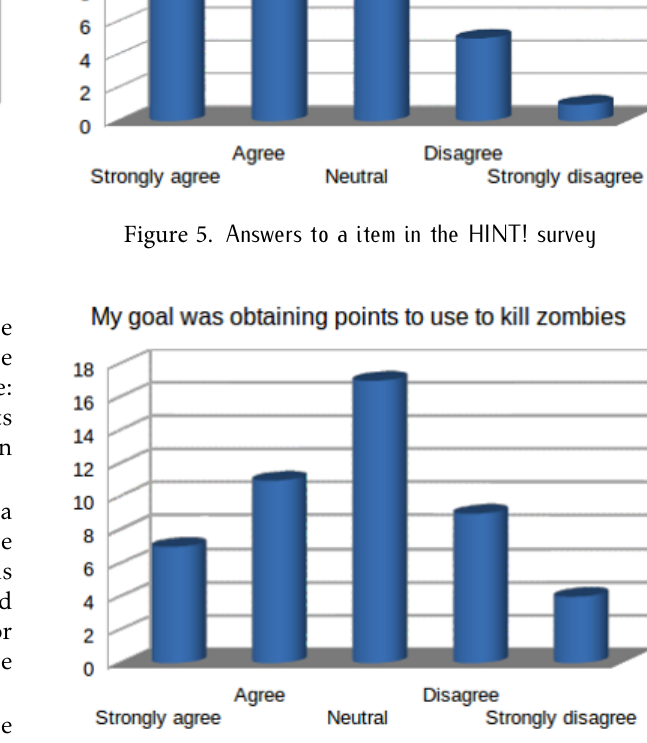
Figure 6. Answers to a item in the Geo-Zombie